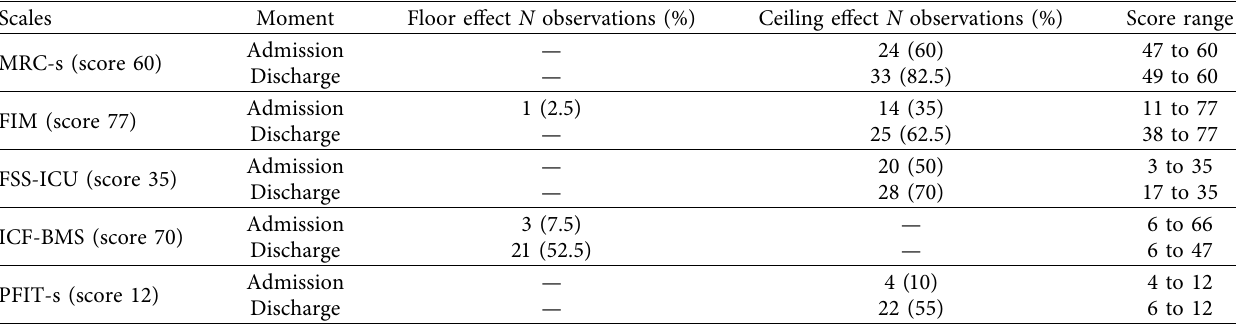
Table 4: Floor and ceiling effects on the use of MRC-s, FIM, FSS-ICU, ICF-BMS, and PFIT-s scales at the ICU admission and